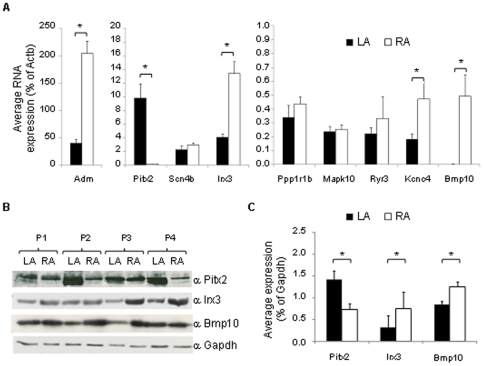
A) RT-qPCR measurements of orthologous transcripts in left atrial (black) and right atrial (white) human appendages (n = 5).
Actb was used as control. Error bars indicate standard error of the mean (SEM). Statistically significant differences as assessed by paired Student's t-test are represented by asterisks (*P<0.05). B) and C) PITX2, IRX3, and BMP10 protein expression level measured by Western blot of total protein lysates from human left (black) and right (white) atrial appendages (n = 4). The data shown are averages of the results obtained from four separate samples. Error bars indicate standard deviation (SD). Statistically significant differences as assessed by unpaired Student's t-test are represented by asterisks (*P<0.05).